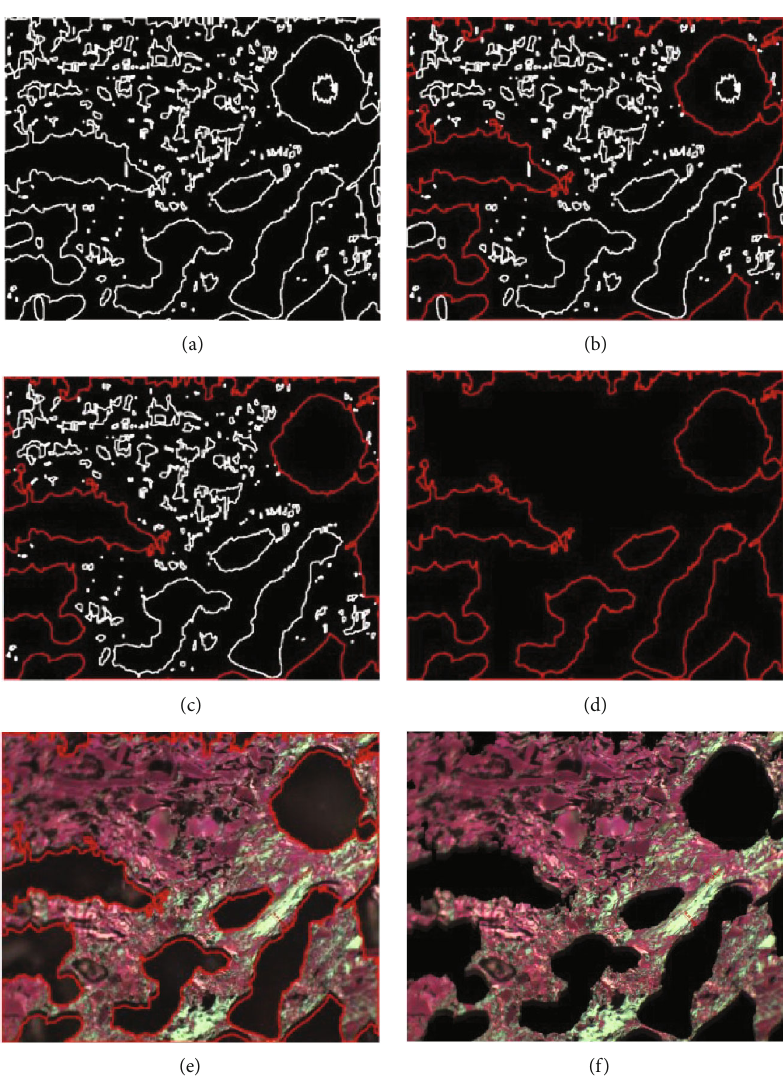
Figure 10: Pixel extraction of the main body in COT image: (a) all contours; (b) the largest contour marking; (c) the largest contour and internal contours; (d) contour of the main body; (e) match the original image; (f) pixels of the main body in COT